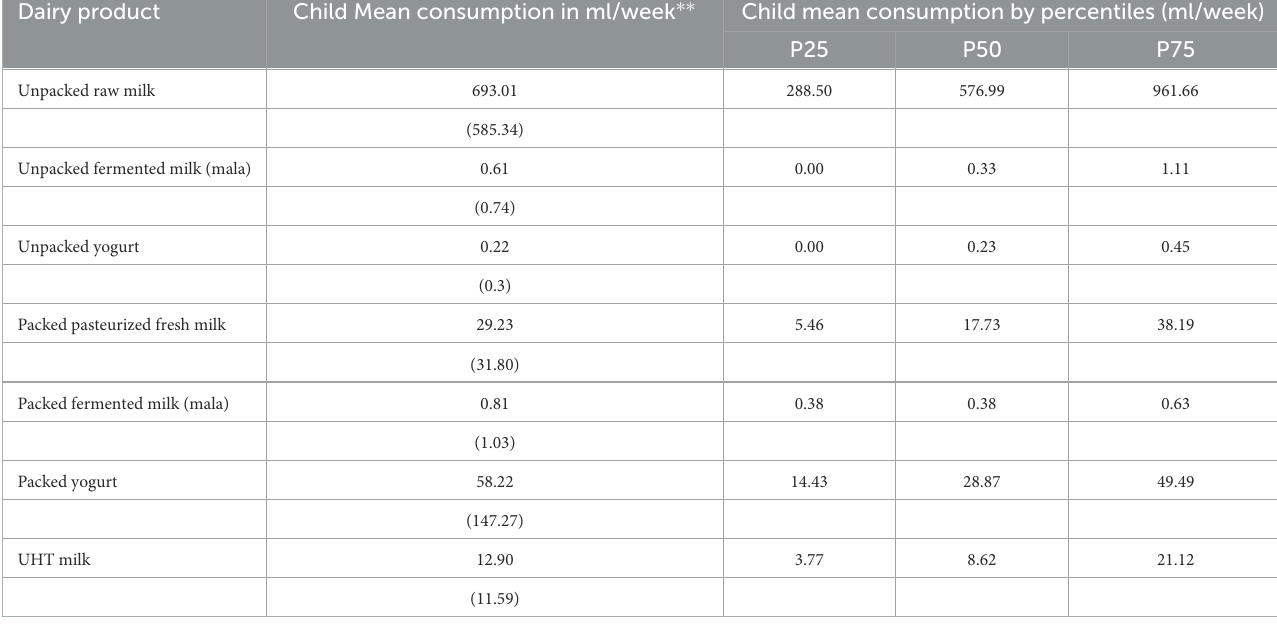
TABLE 6 Mean consumption of dairy products by children between 6 and 48 months. Dairy